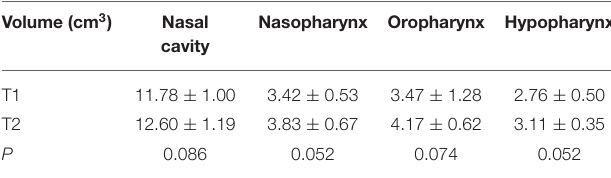
TABLE 1 | Comparison between pre- and post-RME airway volume